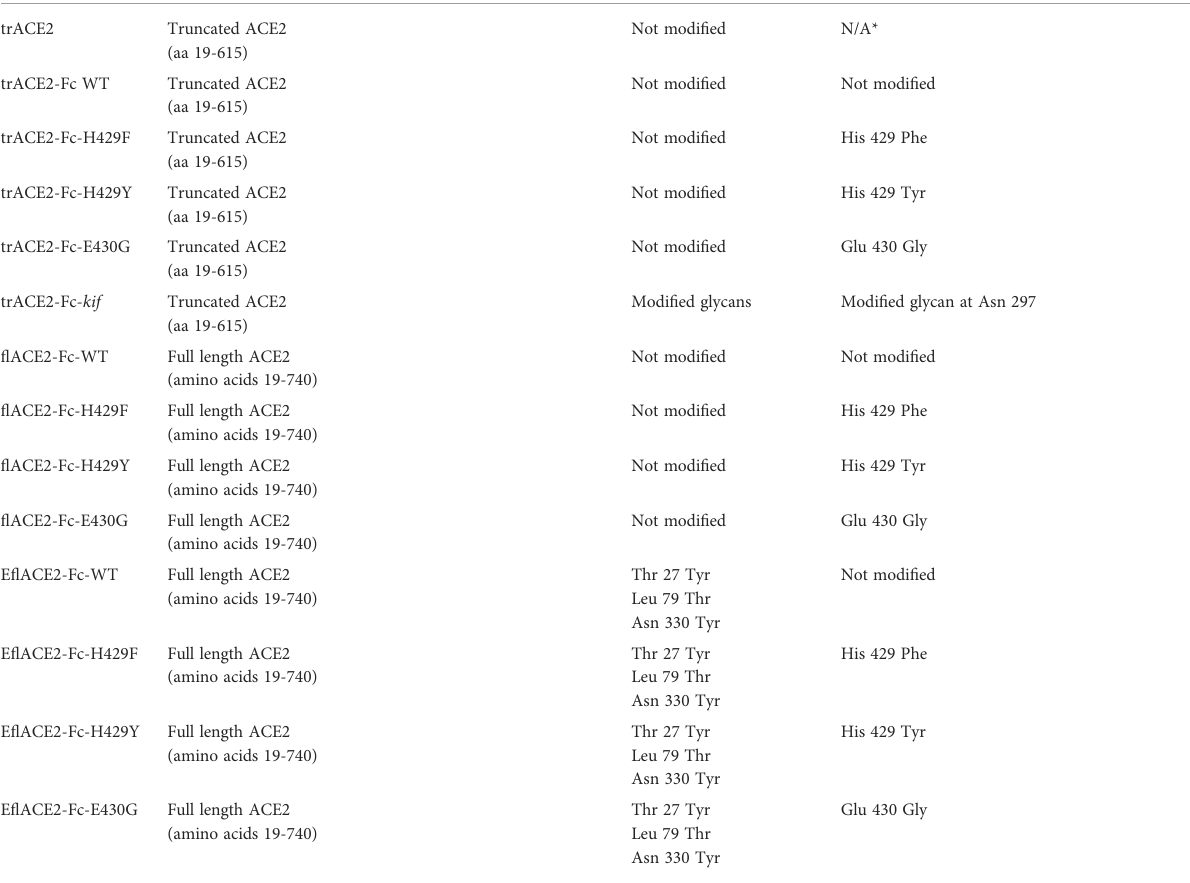
TABLE 1 ACE2 proteins used in this